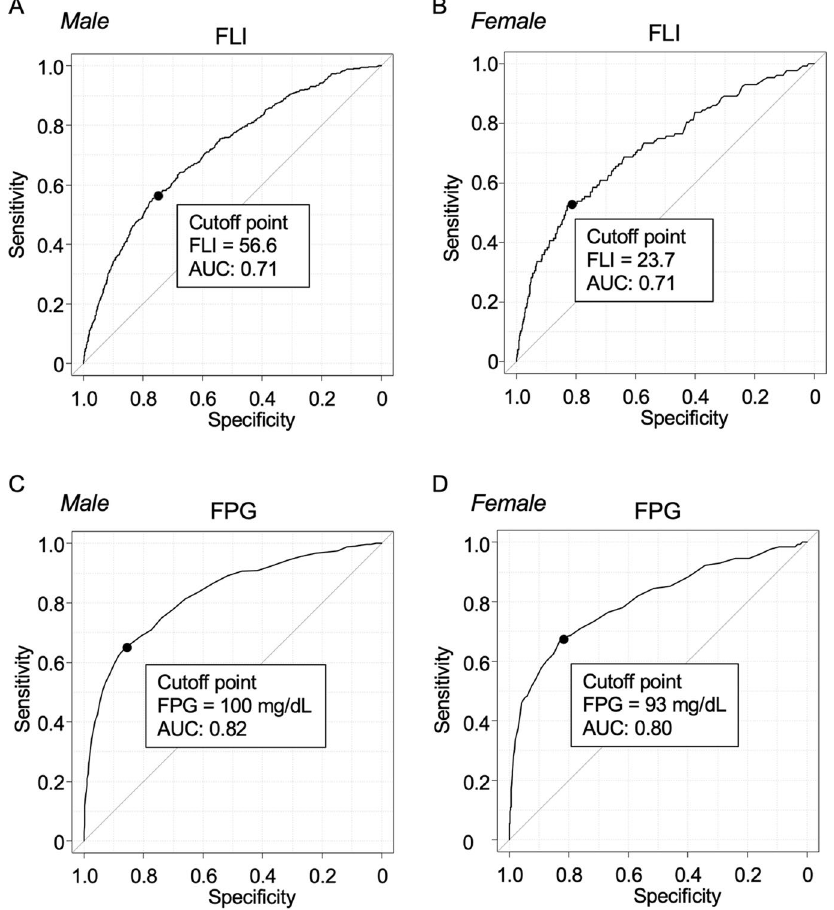
Figure 2. Prediction of new onset of DM by FLI and FPG at baseline. ( A , B ) Receiver operating characteristic (ROC) curves of fatty liver index (FLI) at baseline to predict new onset of diabetes mellitus (DM) in males ( A ) and females ( B ). ( C , D ) ROC curves of fasting plasma glucose (FPG) at baseline to predict new onset of DM in males ( C ) and females ( D ). AUC area under curve, CI confidence